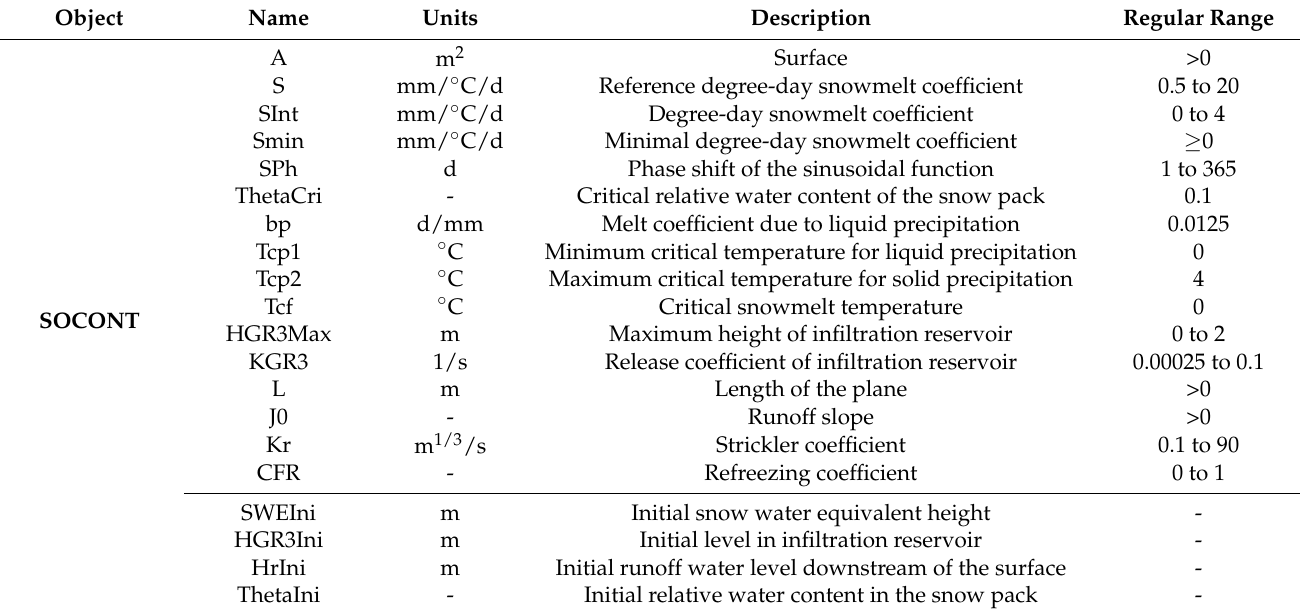
Table 6. SOCONT model parameters and plugins